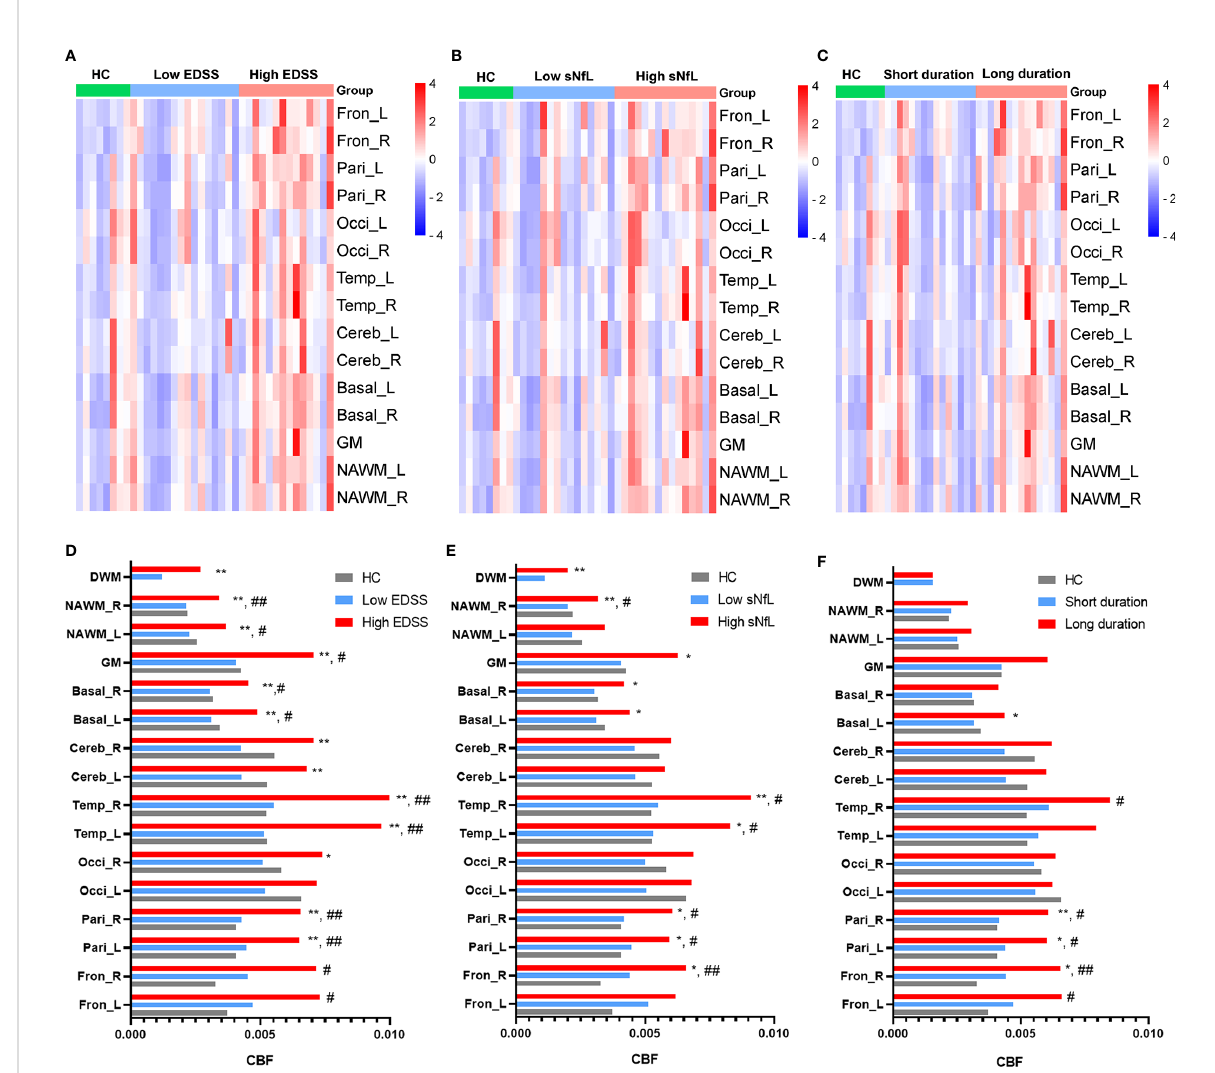
FIGURE 2 Relationship between CBF and clinical parameters. Comparisons of CBF differences in different regions among: (A) HCs, MS patients with low EDSS scores, and MS patients with high EDSS scores; (B) HCs, MS patients with low sNfL, and MS patients with high sNfL; and (C) HCs, MS patients with short disease duration, and MS patients with long disease duration. (D – F) Comparison of CBF of different regions according to clinical parameters (EDSS, sNfL, and disease duration). * p < 0.05 and ** p < 0.01 vs. low EDSS group/short duration group/low sNfL group; # p < 0.05 and ## p < 0.01 vs.